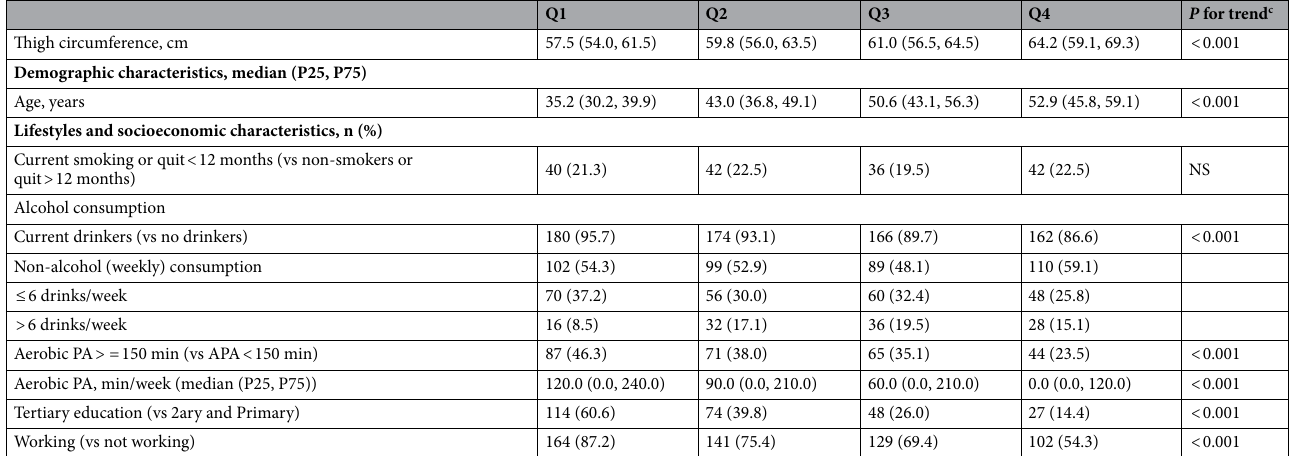
Table 1. Participants’ characteristics by anthropometrically-predicted visceral adipose tissue (VAT) quartiles stratified by sex: European Health Examination Survey in Luxembourg, 2013–2015 (N = 1441). Missing values range from 1 to 14 observations; Q: quartile.Q1 (≤ 113.84), Q2 (113.85—151.59), Q3 (151.60- 196.65), and Q4 (≥ 196.66) for men and Q1 (≤ 58.78), Q2 (58.79- 89.38), Q3 (89.39- 127.35), and Q4 (≥ 127.36) for women. n number, ∆Low HDL cholesterol was defined as blood as HDL-C less than 50 mg/dL for women and 40 mg/ dL for men. a Hypercholesterolemia was defined as total cholesterol ≥ 190 mg/dL or on medication to reduce cholesterol. b High LDL-Cholesterol was defined as blood LDL-C ≥ 115 mg/dL. c Cochran-Armitage trend test fo categorical variables and Jonckheere-Terpstra test for continuous